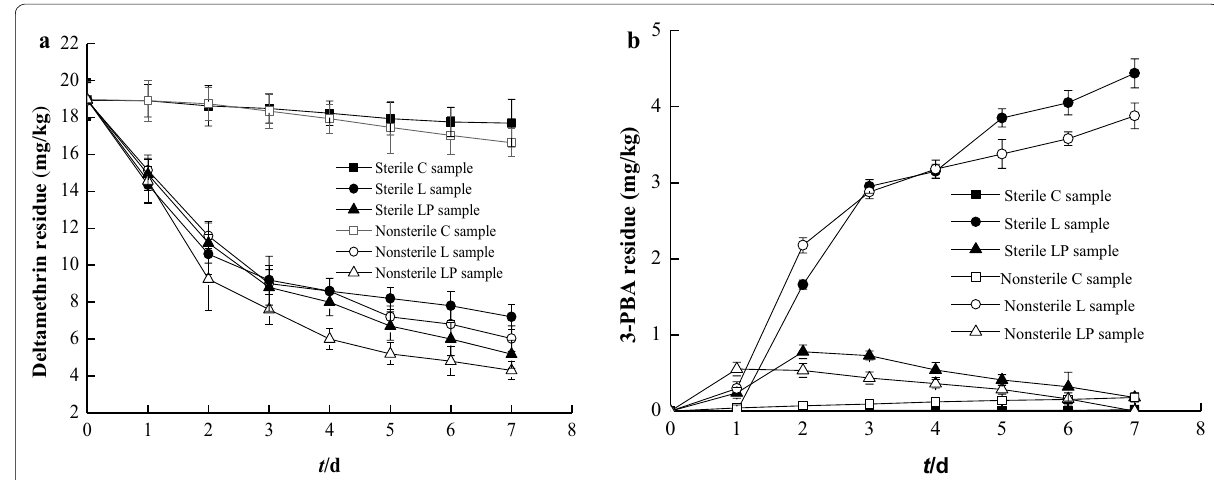
Fig. 7 Deltamethrin residue a and 3-PBA residue b in the sterile soil and nonsterile soils by monoculture strain A. junii LH-1-1 (L sample), the co-culture A. junii LH-1-1 and K. pneumoniae BPBA052 (LP sample), and the uninoculated control (C